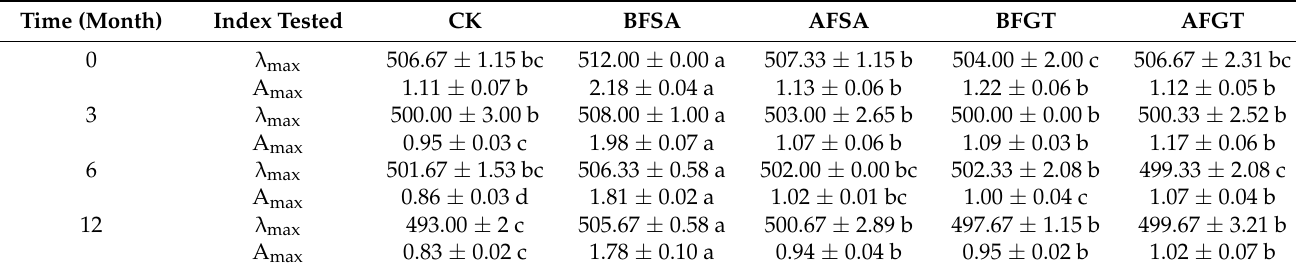
Table 1. Effects of added sinapic acid and grape tannin on λ max and A max of cherry